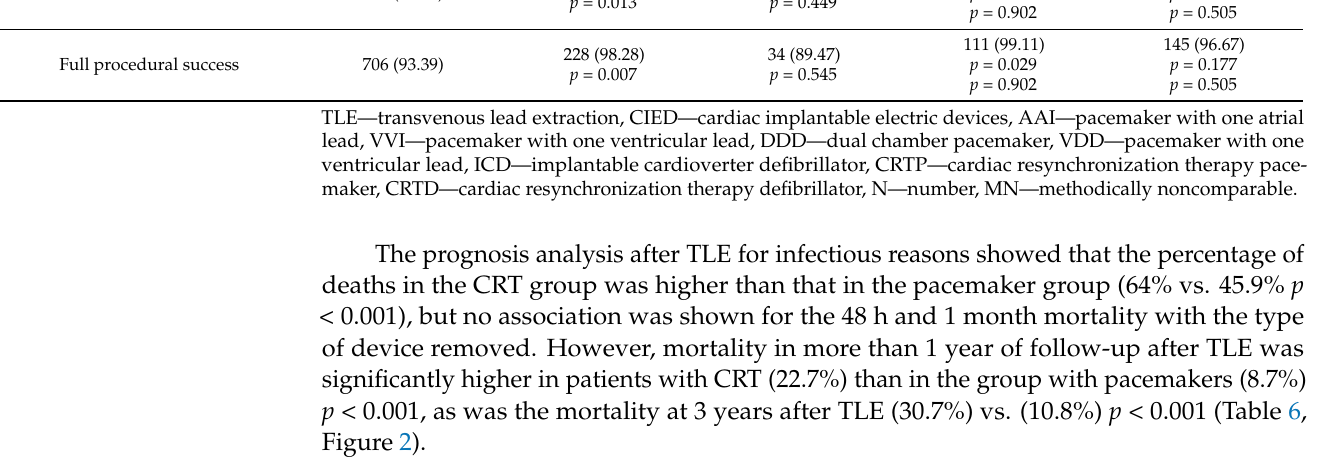
Table 6. Prognosis in short-, mean- and long-term follow-up in compared groups of